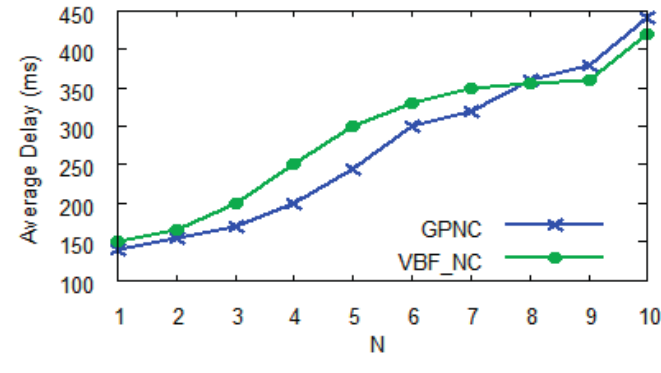
Figure 6. Impact of N on network delay.